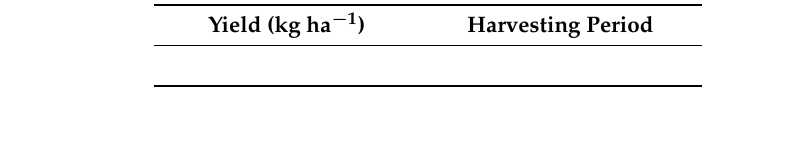
Table A4. Information on yield and harvesting period. Indicate yield and harvesting period (e.g., 30 t ha − 1